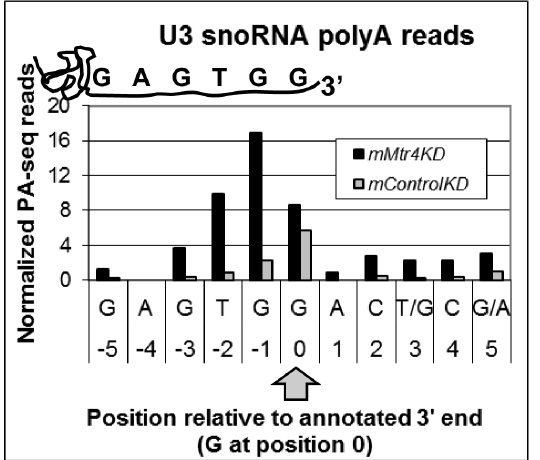
Figure 4. Adenylated U3 snoRNAs from Chromsome 11 (U3B.1- U3B.4) differentially accumulate in the mMtr4 KD. This histogram reports the level of adenylation at individual positions of U3B snoRNAs. Positions are shown relative to the 3 9 end of the snoRNA, as indicated schematically above, and by an arrow below the x-axis. Adenylated RNAs terminating immediately 5 9 (positions 2 1 thru 2 3) relative to the canonical 3 9 end of the snoRNA (position 0) are cumulatively 9-fold more abundant in the mMtr4 KD relative to the mControl